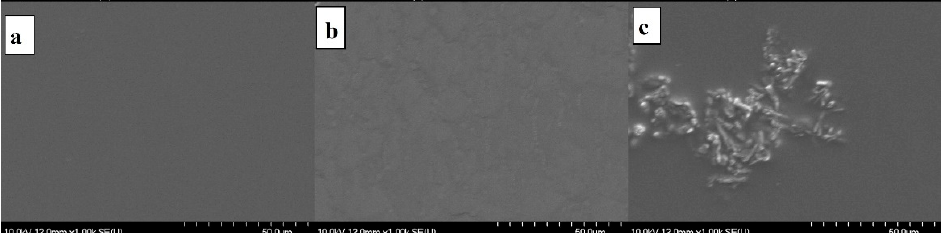
Figure 9. Scanning electron micrographs of chitosan ascorbate films at 1000× magnification (API-free film (Film 2) ( a ), cetirizine HCl-loaded film, ( b ) and diclofenac Na-loaded film ( c )).